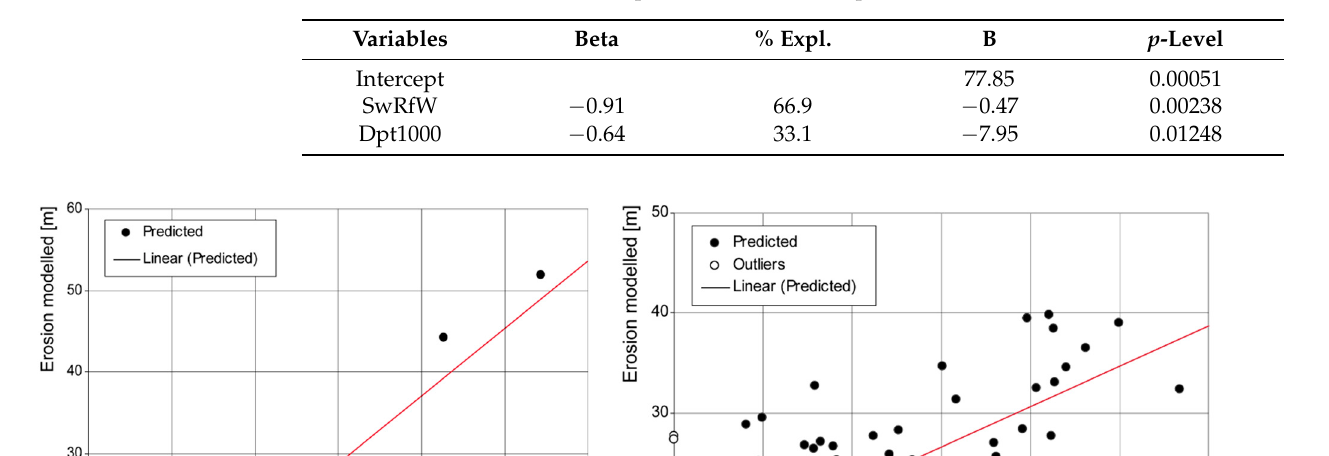
Table 4. Results from statistical regression, cases without coral protection, with TotSgW as the total width of seagrass meadows in meter, Depth6 as the minimum distance where a six meters water depth is recorded and Irbn10y as the Iribarren number (Komar, 1998) calculated for a 10 year return lowest the p -level the highest the confidence in the selection. In this study the range period.